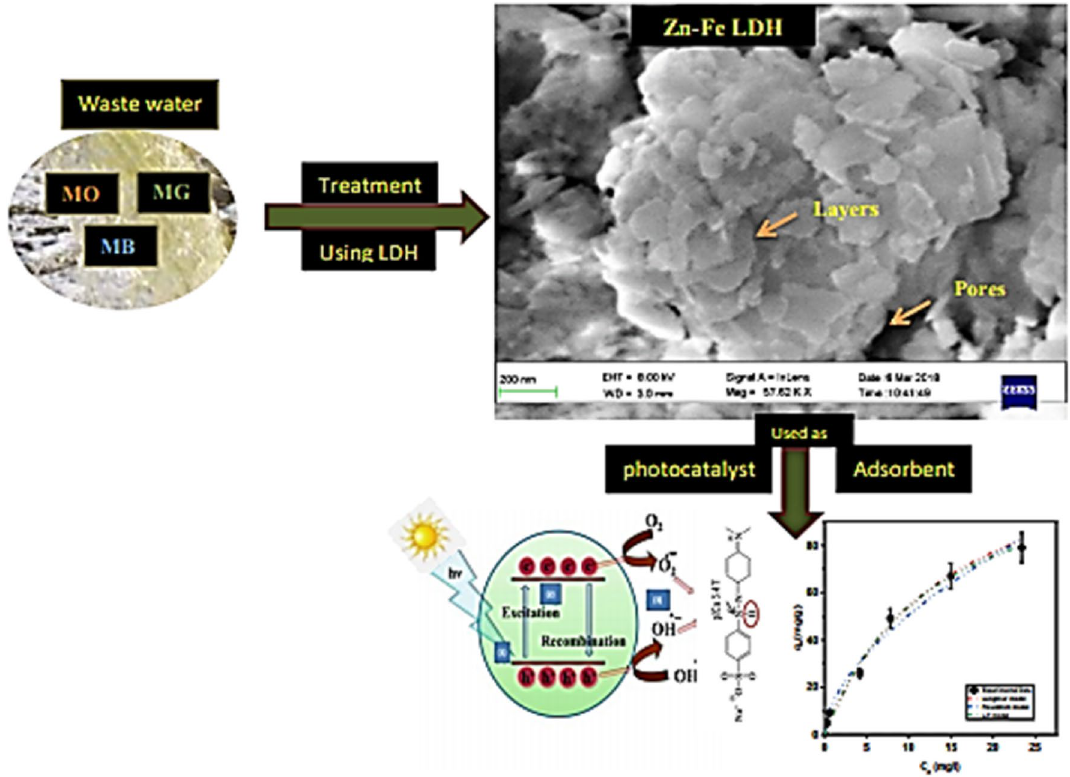
Figure 1. The proposed application performed using Zn–Fe